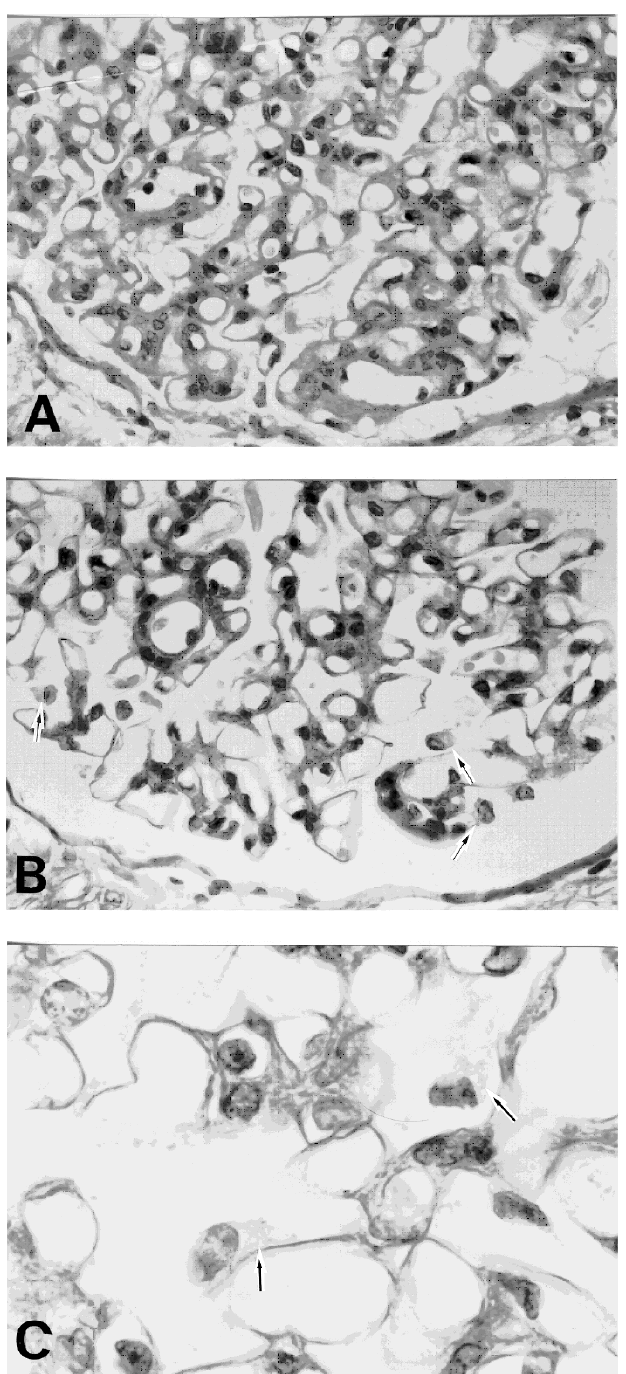
Fig. 2. In situ hybridization using α 1 (VI) chain antisense oligo-DNA probe showing mRNA positive epithelial cells (arrow) in the diabetic glomeruli (B, C). Occasional mRNA positive mesangial cells, midst of PAS positive mesangial matrix are also noted. Adjacent section hybridized with sense probe disclosing no specific signals (A) (PAS